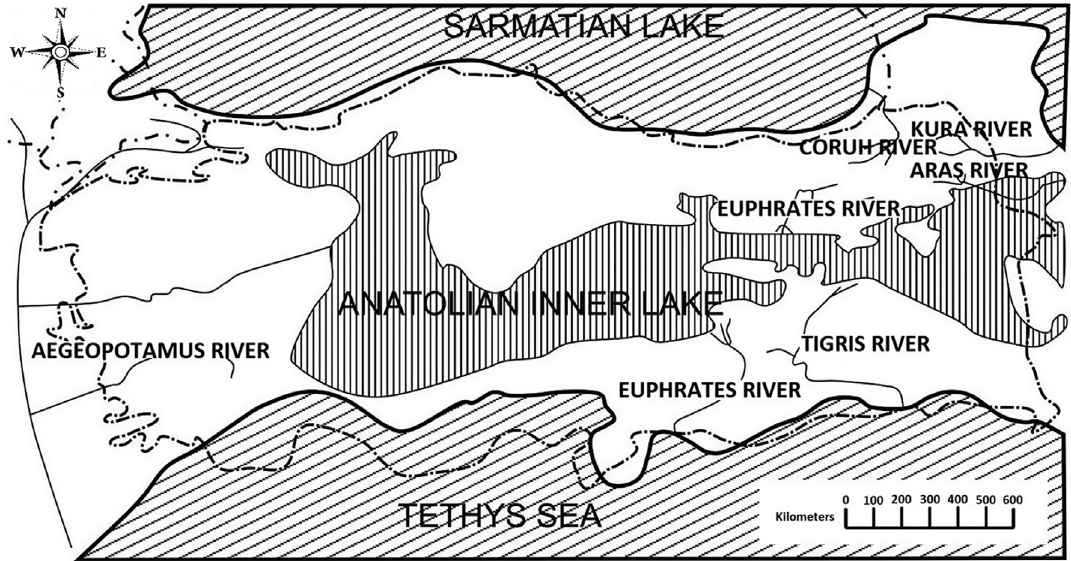
Figure 2. The drainage system of the historic Inner Anatolian freshwater Lake of the Middle Miocene-Pliocene period based on Demirsoy (2008). The drainage is shown to include the Aras, Murat, and Euphrates rivers. Striped lines mark the present borders and coasts of